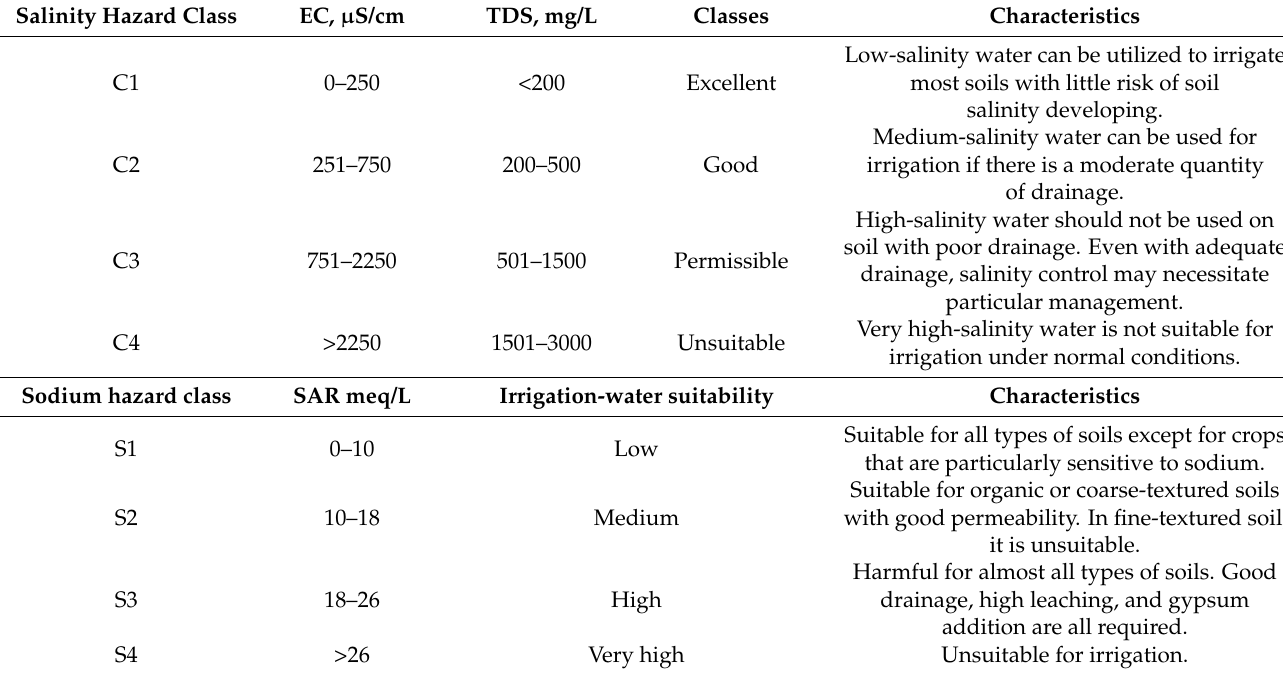
Table 9. Classification of irrigation water for salinity hazard and sodium